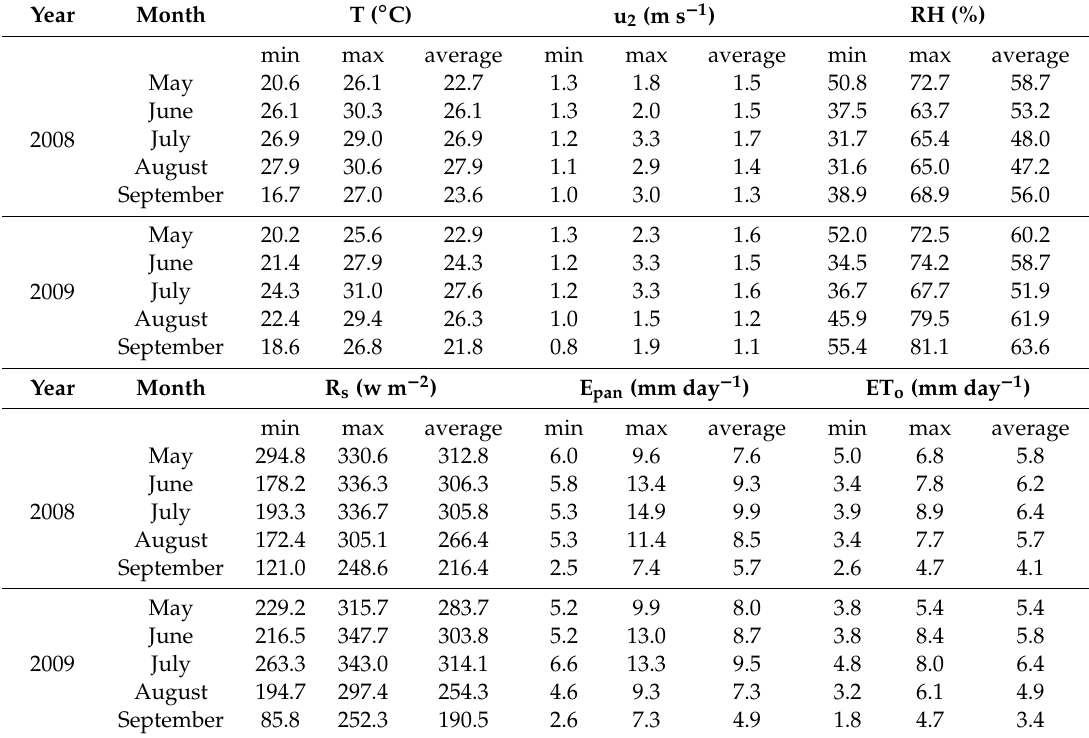
Table 1. Minimum, maximum, and average values of daily temperature (T), wind speed at 2 m above ground surface (u 2 ), relative humidity (RH), incident solar radiation (R s ), measured Class A pan evaporation (E pan ), and estimated reference evapotranspiration according to the ASCE-standardized method (Equation (1)) after excluding rainfall